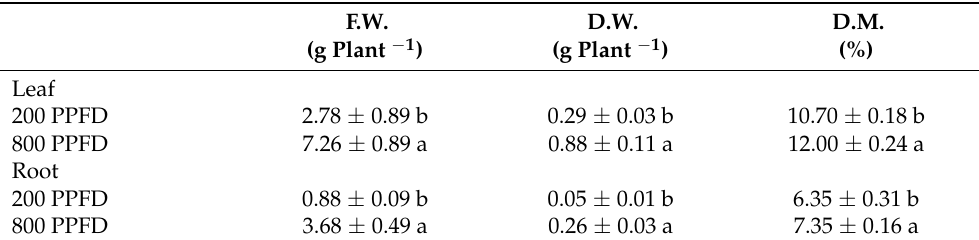
Table 1. Growth parameters in spinach plants grown in a growth chamber under 800 µ mol m − 2 s −